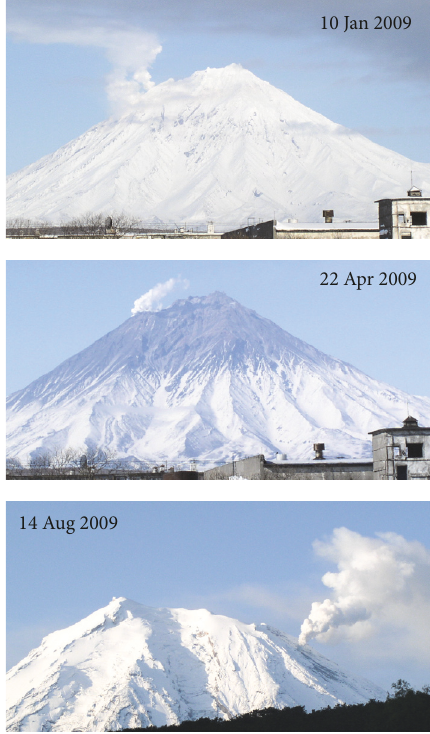
Figure 19: Koryaksky Volcano burst of activity in 2009. Photo by A. V. Kiryukhin.